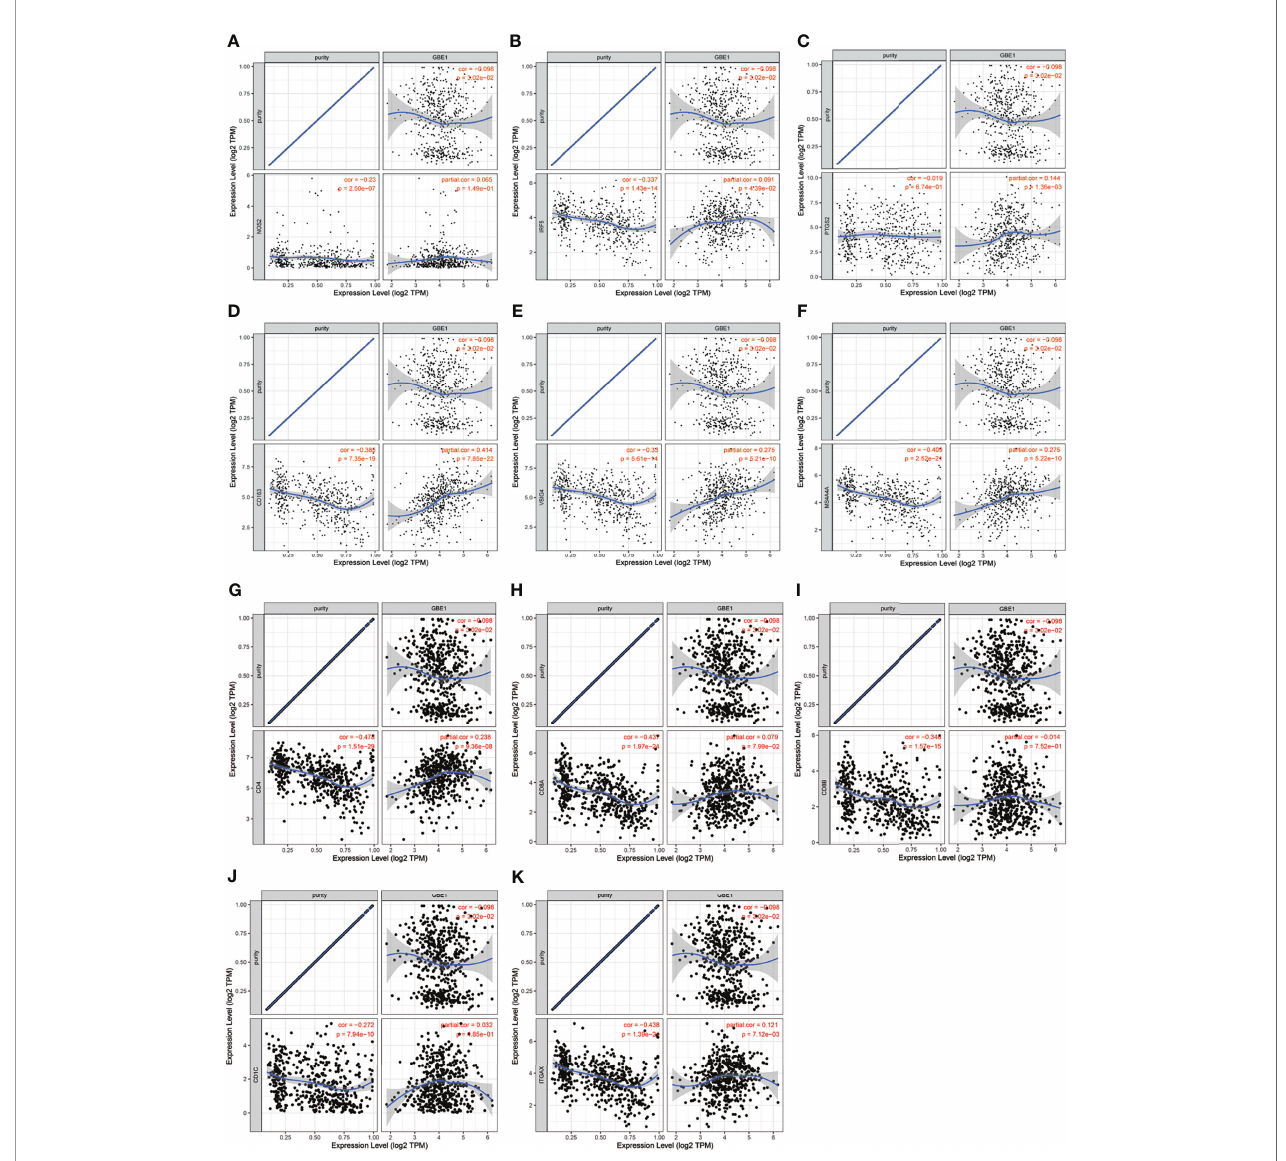
FIGURE 6 | The correlation analysis between GBE1 and gene markers of tumor-associated immune cells in the TIMER database. (A – C) Gene markers of M1 macrophage; (D – F) gene markers of M2 macrophage; (G) gene marker of CD4+ T cell; (H – I) gene markers of CD8+ T cell; (J – K) gene markers of dendritic